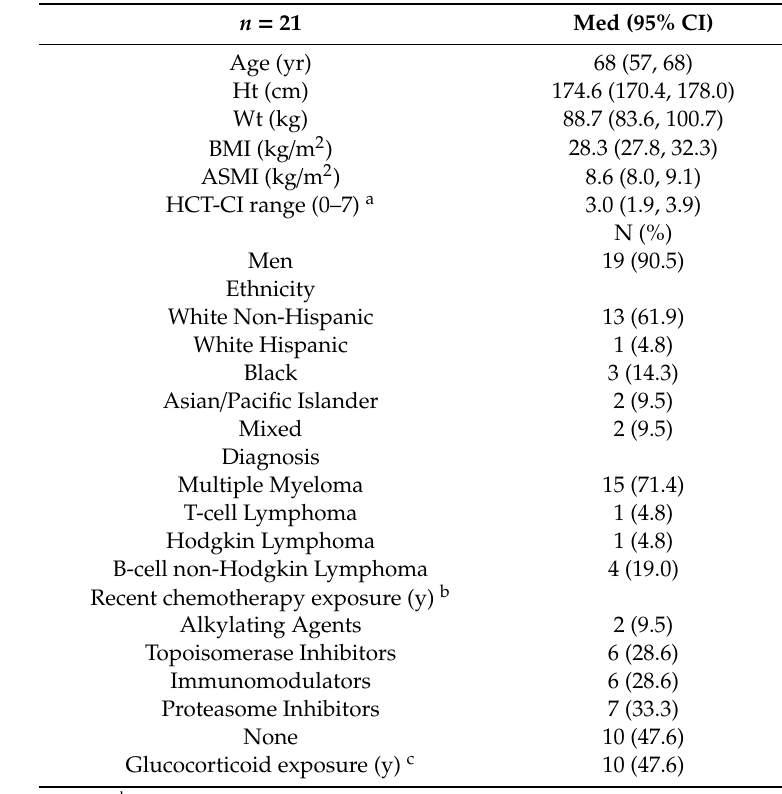
Table 1. Baseline